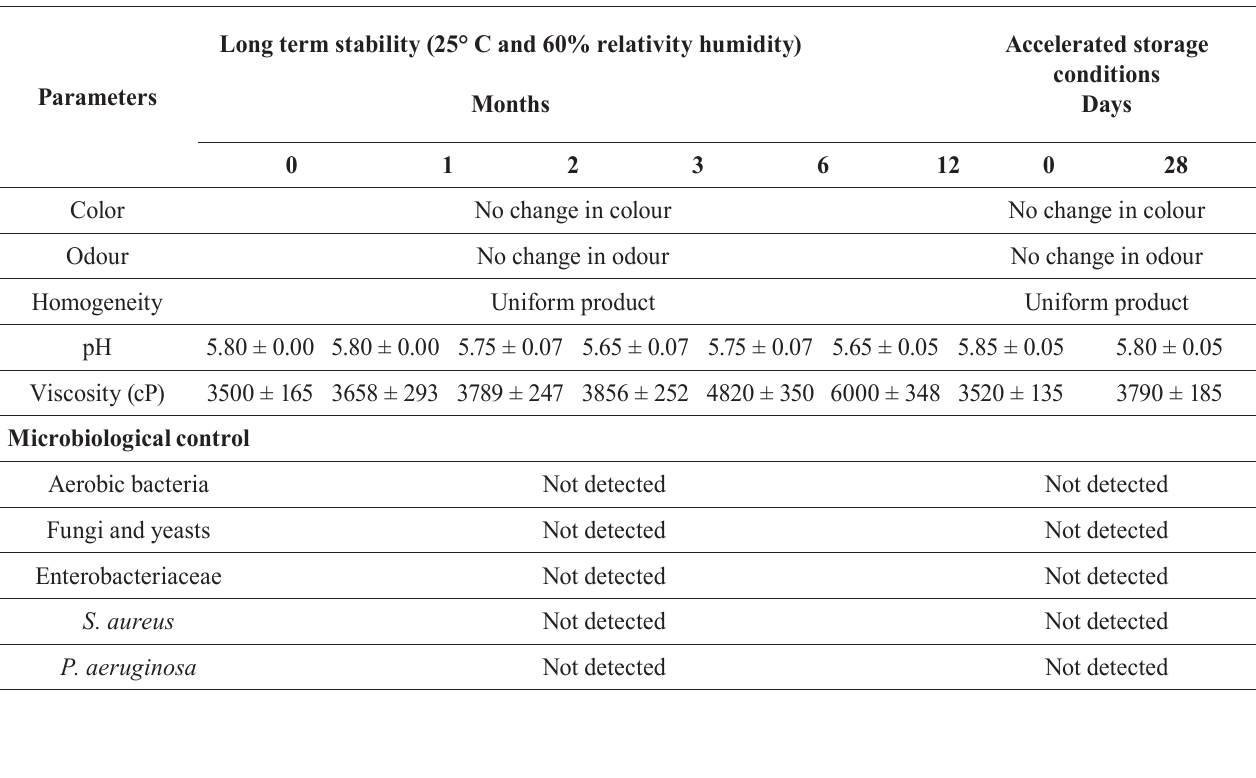
TABLE IV - Stability studies of gel formulation in normal and accelerated storage conditions